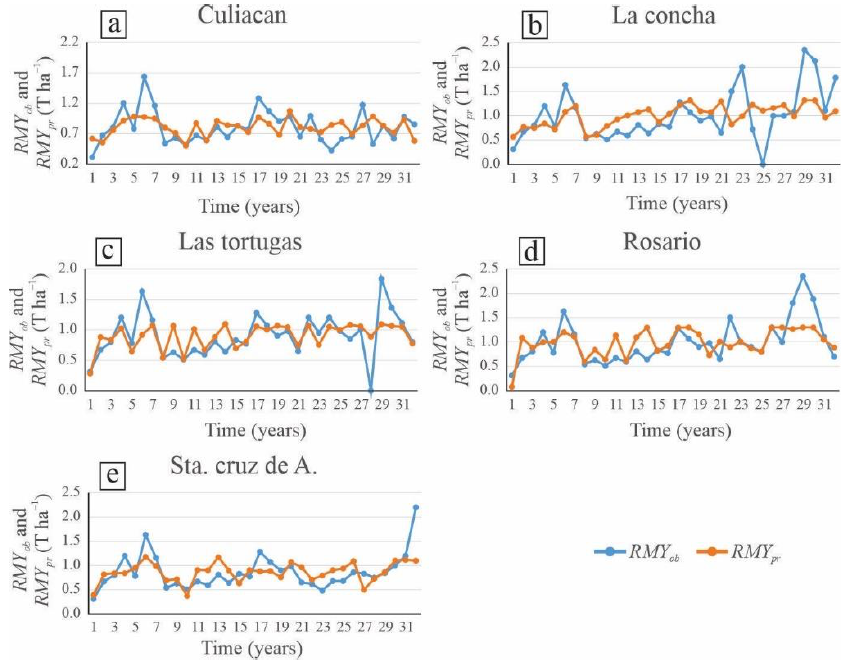
Figure 5. Annual variation of RMY ob and RMY pr (T ha –1 ) ( a – e ). Rosario is the station with the greatest predictive capacity. The predictive capacity of the five models (Equations (15)–(19)) is low ( R 2 < 0.500) but significantly different from zero, especially for Las Tortugas (Equation (17)), Rosario (Equation (18)) and Sta. Cruz de A. (Equation (19)) for aSPI and eRDI for one month (January), two months (December – January) and three months (November – January).